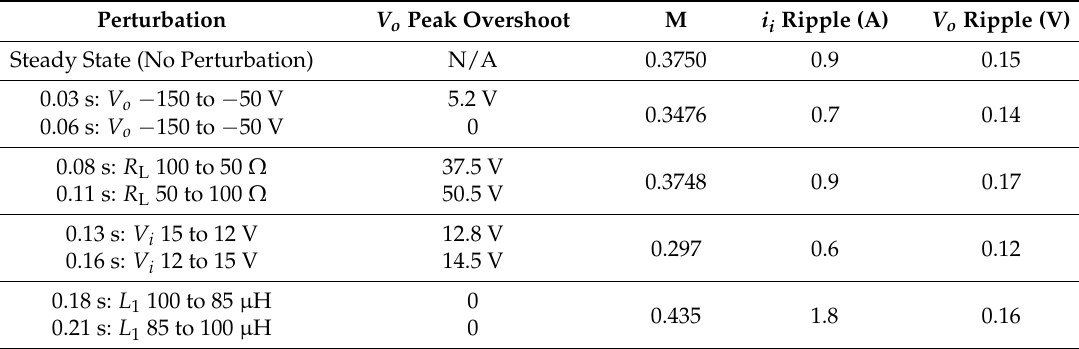
Table 4. Performance indices of modified Ć uk converter.